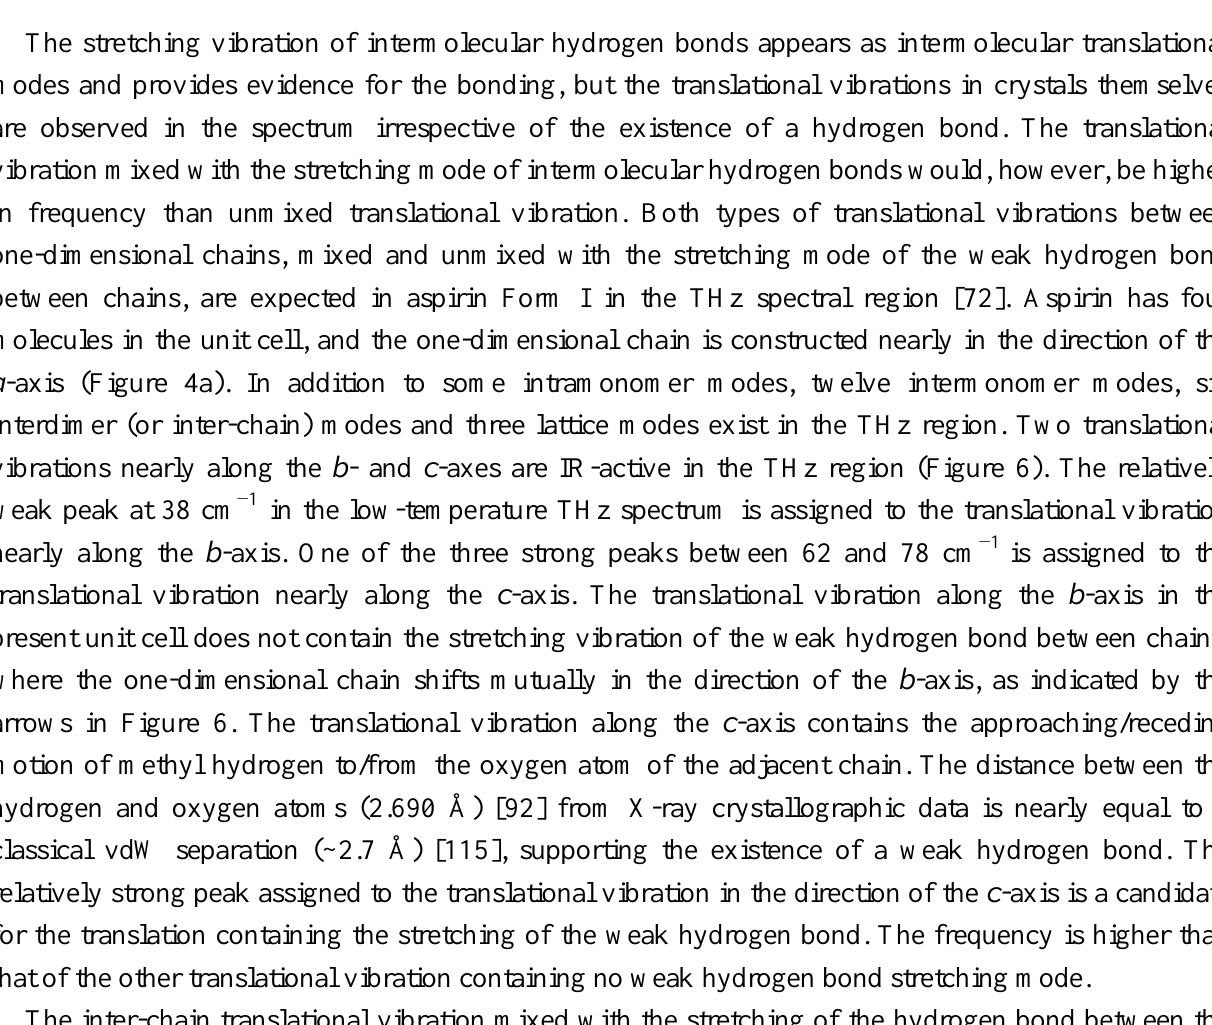
symmetry ( insert ) and the infrared 2